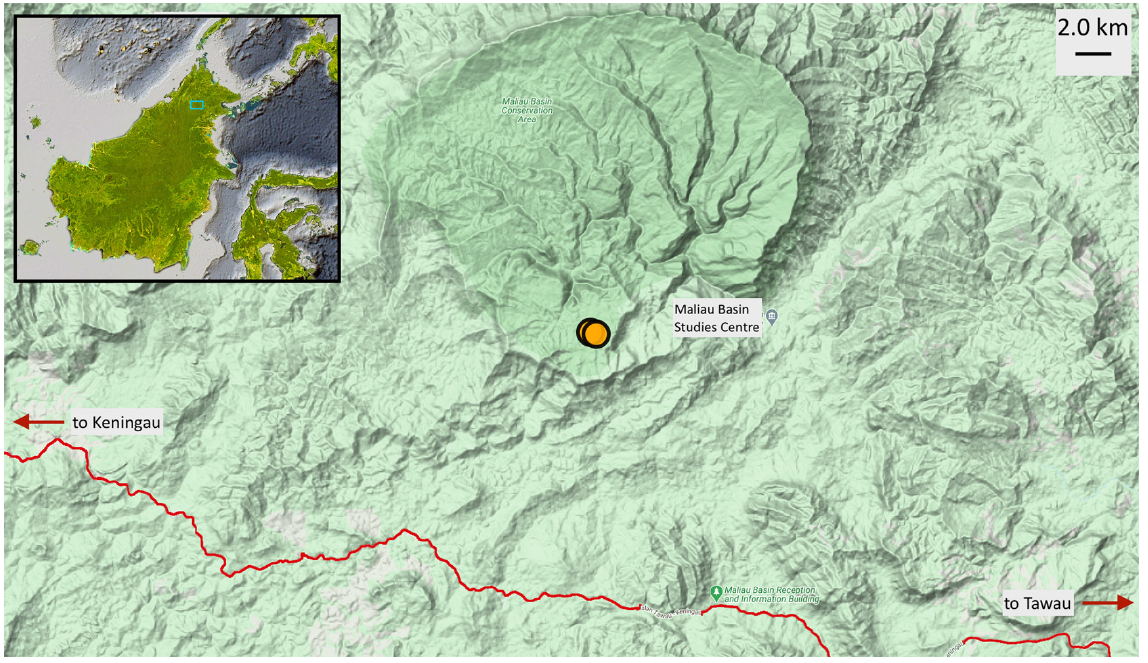
Fig. 11. Map with the position of the two sampling sites in Maliau Basin shown as orange dots. The position of the Maliau Basin area on Borneo is indicated with a blue rectangular in the upper-left